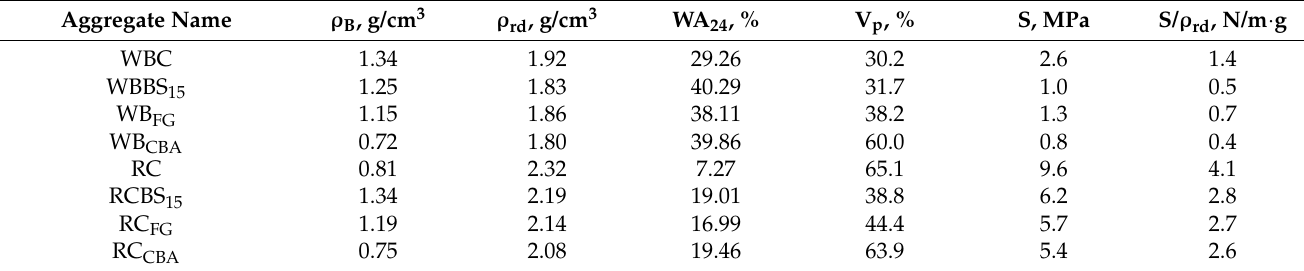
Table 6. Technological properties of the aggregates: ρ B = loose bulk density; ρ rd = oven dry density; WA 24 = water absorption after 24 h immersion; V P = void percentage; S = single aggregate crushing